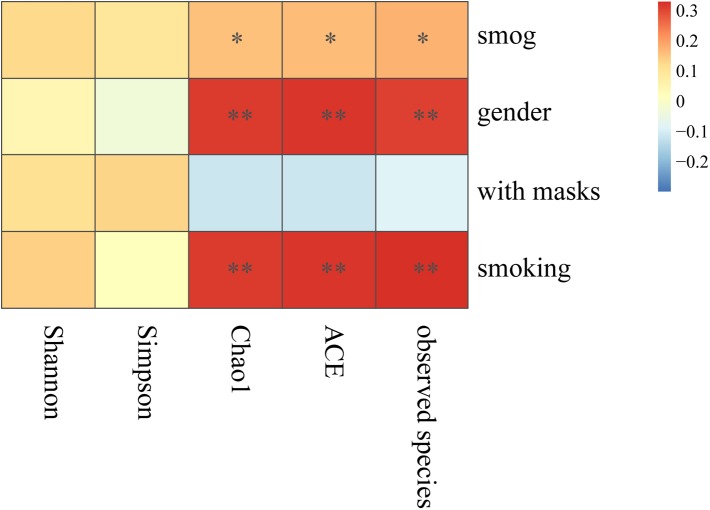
Spearman correlation analysis of influential factors and alpha diversity. ∗p < 0.05, ∗∗p < 0.001.